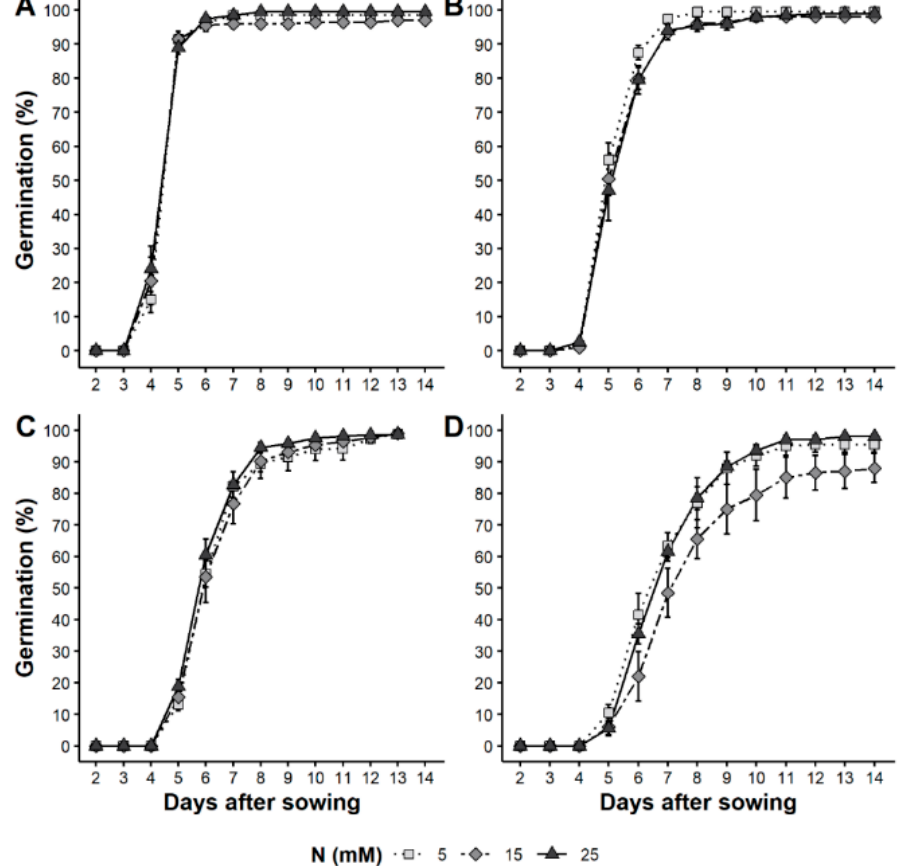
Figure 5. Germination curves after eight months from harvest of seeds from tomato plants fertigated with solutions of 5, 15 or 25 mM nitrogen (N) concentration. ( A ) Germination in water ( Ψ = 0 MPa). ( B ) Germination in − 0.10 MPa water potential solution. ( C ) Germination in − 0.15 MPa water potential solution. ( D ) Germination in − 0.20 MPa water potential solution. Data are an average of four replicates, with two sub-samples of 50 seeds each, and bars represent its standard error. More negative water potential solutions significantly increased MGT for all N treat- ments ( p < 0.001; Table 2) with no significant differences between treatments ( p = 0.922, 0.071, 0.506 and 0.133, respectively, for germination in water, − 0.10, − 0.15 and − 0.20 MPa solutions). A significant reduction in MGT was observed for all treatments when seeds were evaluated at eight months after harvest compared to the evaluation at five months after harvest ( p < 0.001; Table 2). The %G increased when evaluated in the − 0.10 MPa solution at eight months after harvest compared to the evaluation at 5 months ( p < 0.001; Table